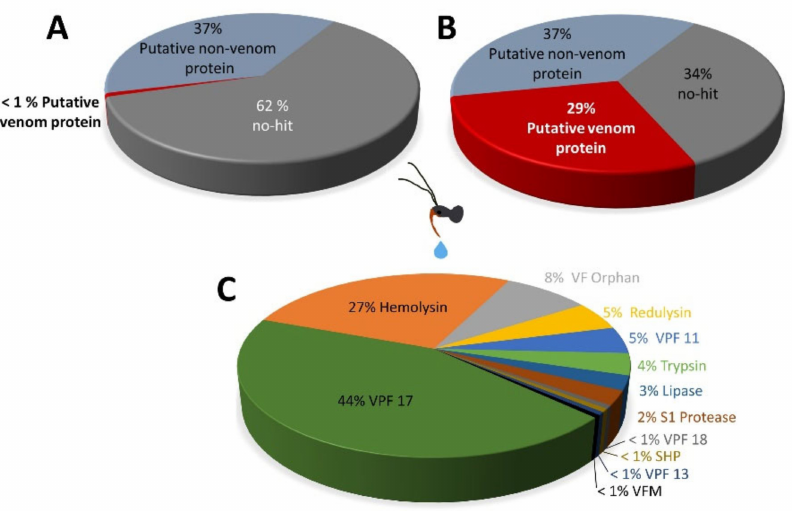
Figure 6. Types of transcripts found in Rhynocoris iracundus venom gland. ( A ) Relative proportion of venom protein encoding genes, non-venom protein encoding genes, and transcripts designated as “no-hit” (unknown). Venom protein genes account for <1% of the total transcripts ( B ) represents the relative transcript expression levels of the same categories. Among them, 29% of all sequence read counts of the transcripts are associated with the category “putative venom protein”. ( C ) Relative expression levels of toxin encoding genes only, displayed as % transcript expression of total putative venom protein encoding